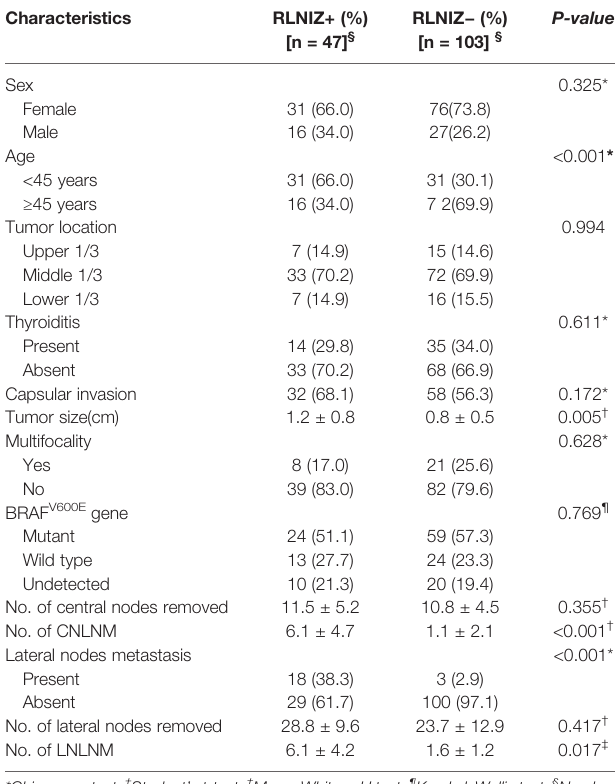
TABLE 1 | Clinical characteristics of patients with primary surgery for PTC who had lymph nodes in RLNIZ. Characteristics